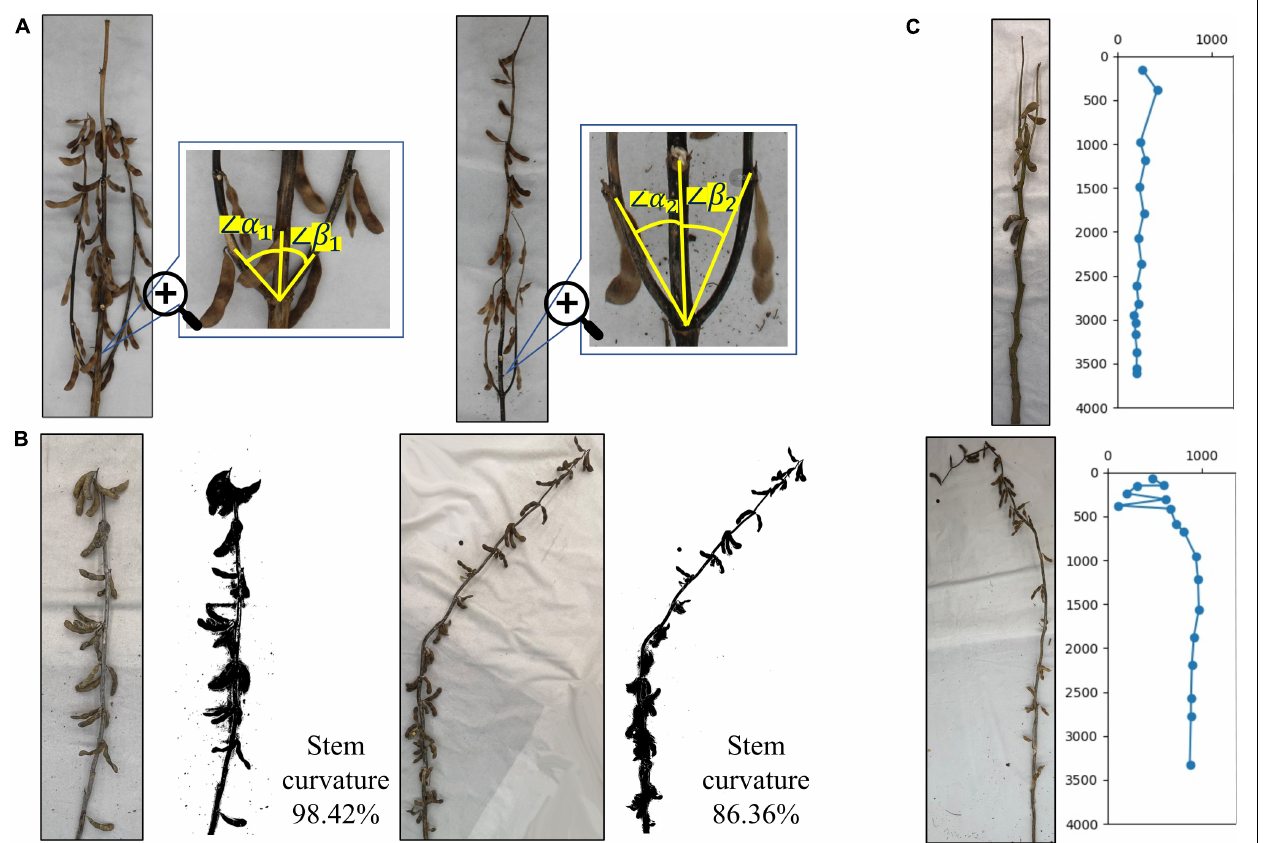
FIGURE 13 | Identification of branch morphology, stem curvature, and specific plants: (A) difference in branch morphology of plants, (B) difference in stem curvature, and (C) identification of specific plants.